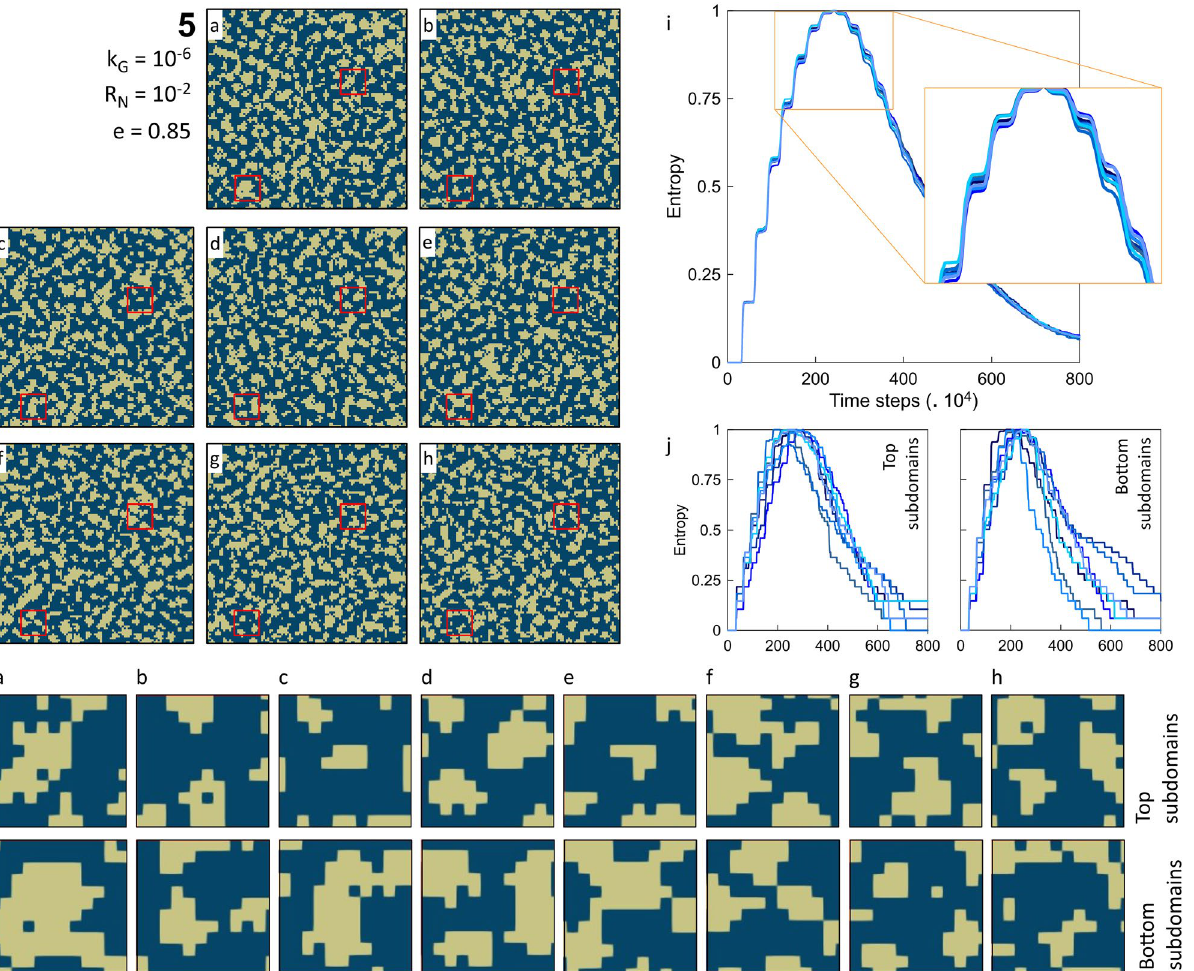
Figure 5. (Left, a – h ) eight different realizations of simulation scenario number 5 (k G = 10 –6 , R N = 10 –2 at e = 0.85) indicating stochastic amount and distribution of surface solid precipitation as implemented in probabilistic nucleation and crystal growth model. The red squares show the crystal accumulation status for two random REV subdomains. The subdomains (top and bottom squares) are enlarged for better comparison for each realization. The simulation number, reaction rate constant (k G ), nucleation rate (R N ), and entropy level (e) are shown. (right, i ) the computed Shannon entropy values for eight realizations during the entire simulation time (× 10 4 ), describing the system’s evolution pathways. (right, j ) the computed Shannon entropy for subdomains (top and bottom squares) during the entire simulation time (× 10 4